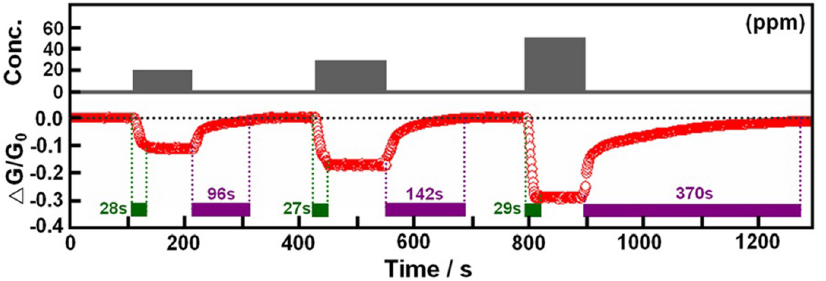
Figure 13. Stability and sensitivity test of gas sensors based on NiO films. The conductance change of NiO films on the glass substrates to 20, 30, and 50 ppm of NH 3 at room temperature